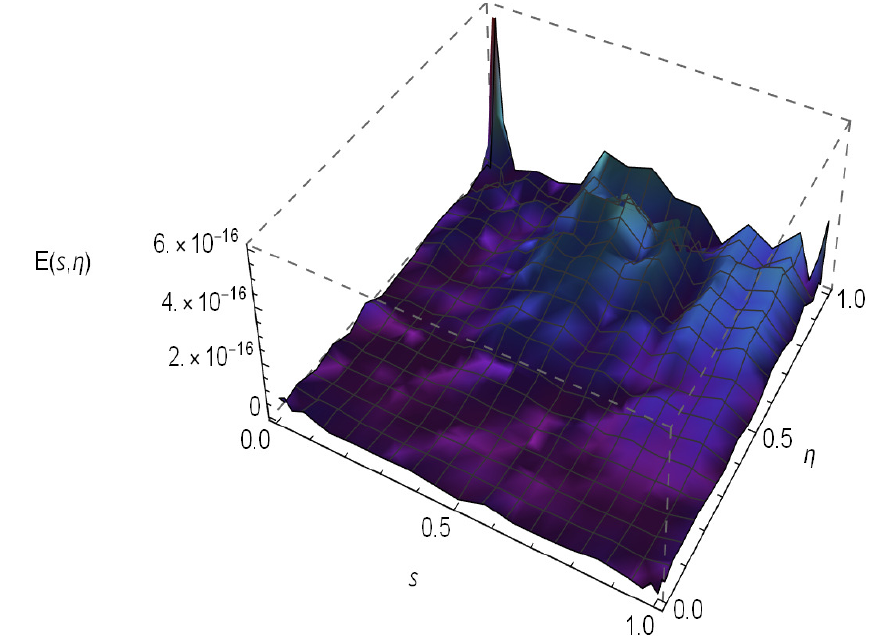
Figure 8. Absolute errors of problem (18), where ε = 1.1, ν = 0.5, N = M =